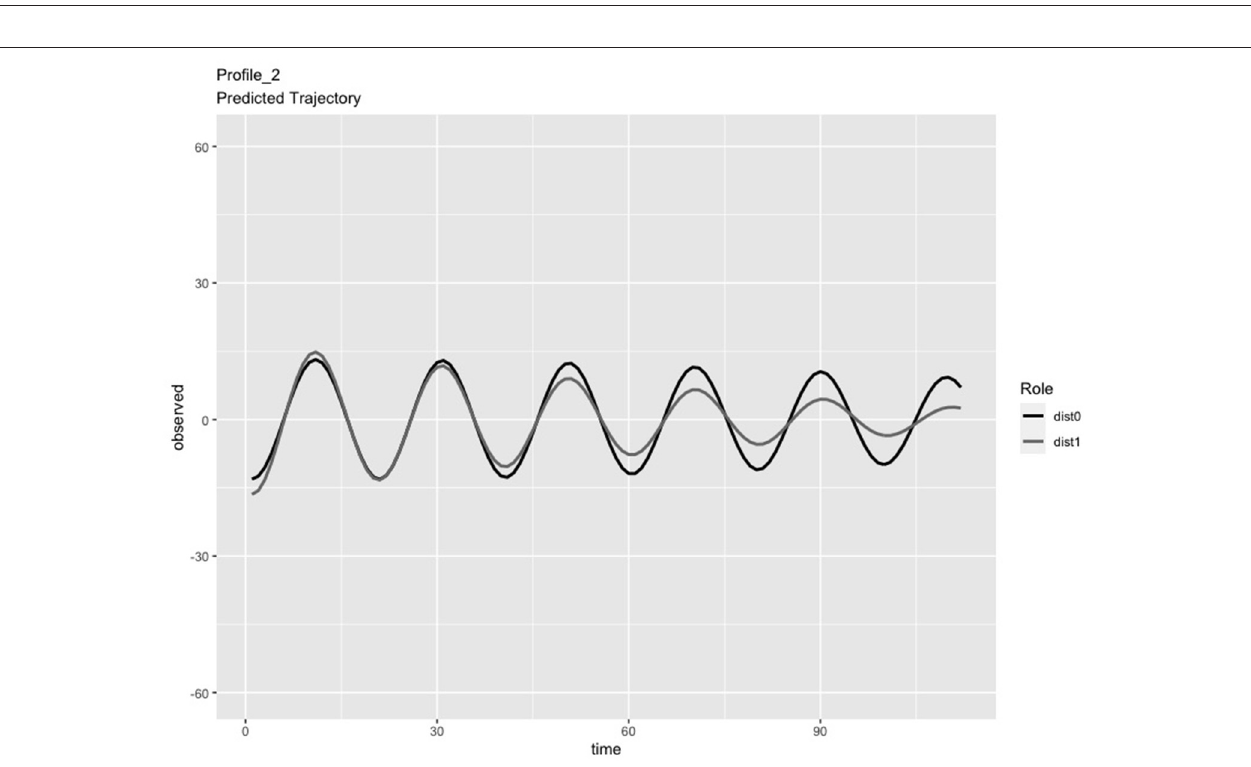
FIGURE 2 | Profile 2, labeled as Simple-Fast, was characterized by a fast frequency, in-phase synchronization pattern that also showed one person’s signal damping over time ( n = 17 dyads).